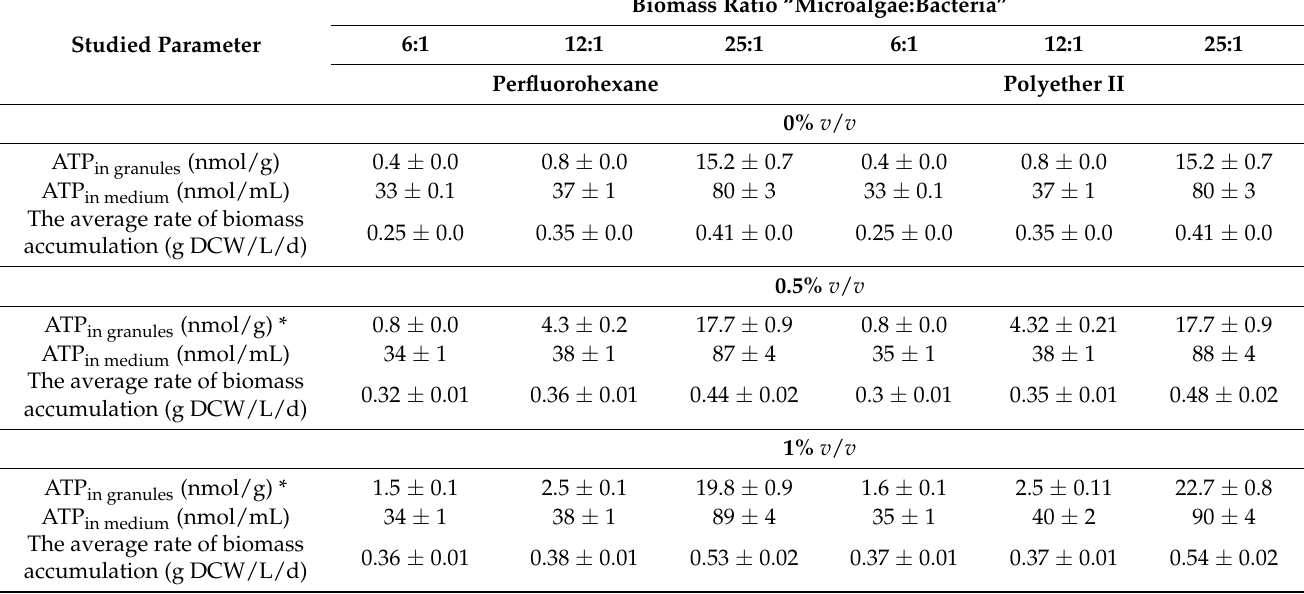
Table 2. Values of study parameters established after 72 h of cultivation of an immobilized consortium of P. esterophilus bacteria with R. ruber and C. vulgaris microalgae in wastewater with 0.15 mM methyl